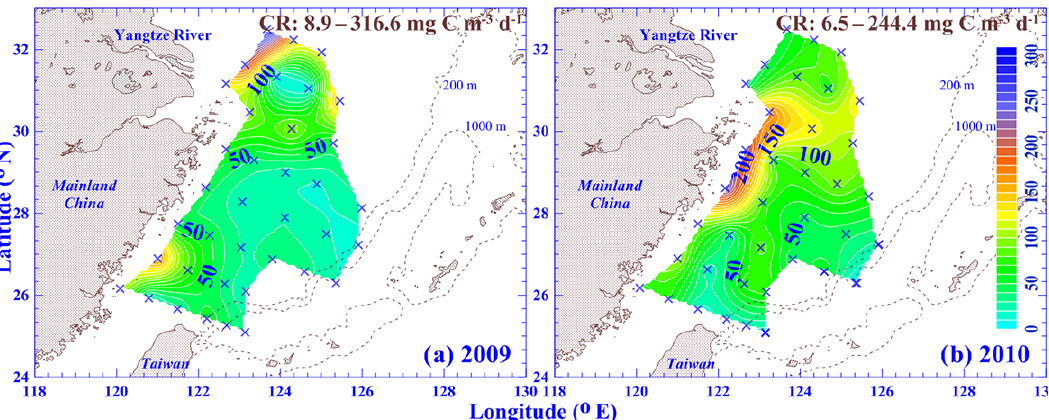
Figure 2. Contour plots of plankton community respiration (CR; mgCm − 3 d − 1 ) over the euphotic zone of the ECS during (a) non-flooding (2009) and (b) flooding (2010) periods. The contour interval is 10mgCm − 3 d − 1 . The CR range is shown at the top of each panel.